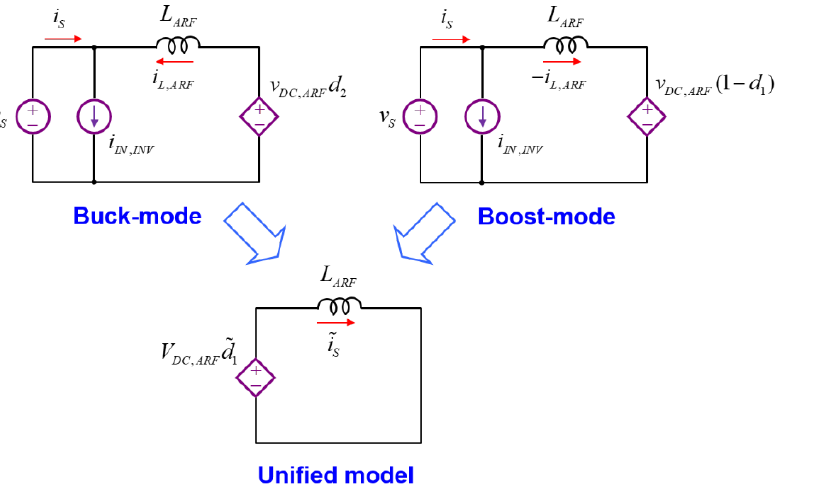
Figure 7. Small-signal equivalent circuit of the current loop.